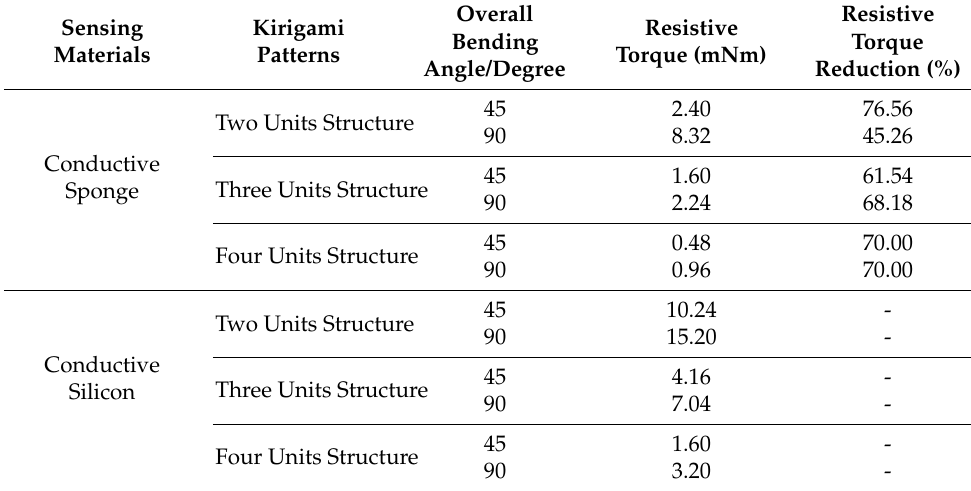
Table 4. Resistive torque generated by sensor